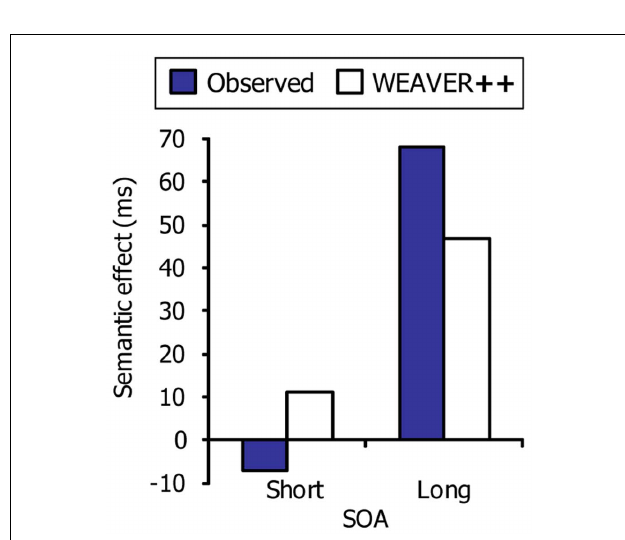
FIGURE 6 |The semantic interference effect in picture naming as a function of stimulus onset asynchrony (SOA) in the psychological refractory period procedure. Shown are the real data (Dell’Acqua et al., 2007) andWEAVER ++ simulation results.The short SOA was 100ms and the long SOA was